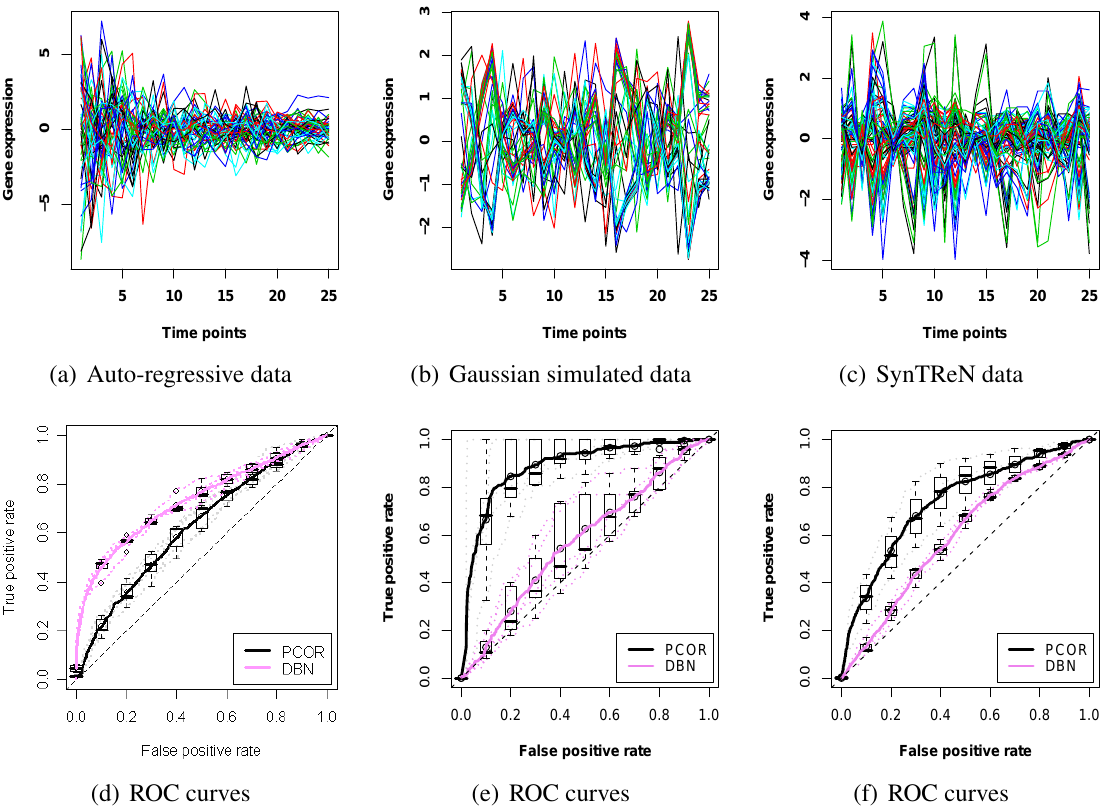
Figure 6: Comparisons of performance of GGMs / PCOR and DBNs in the analysis of synthetic